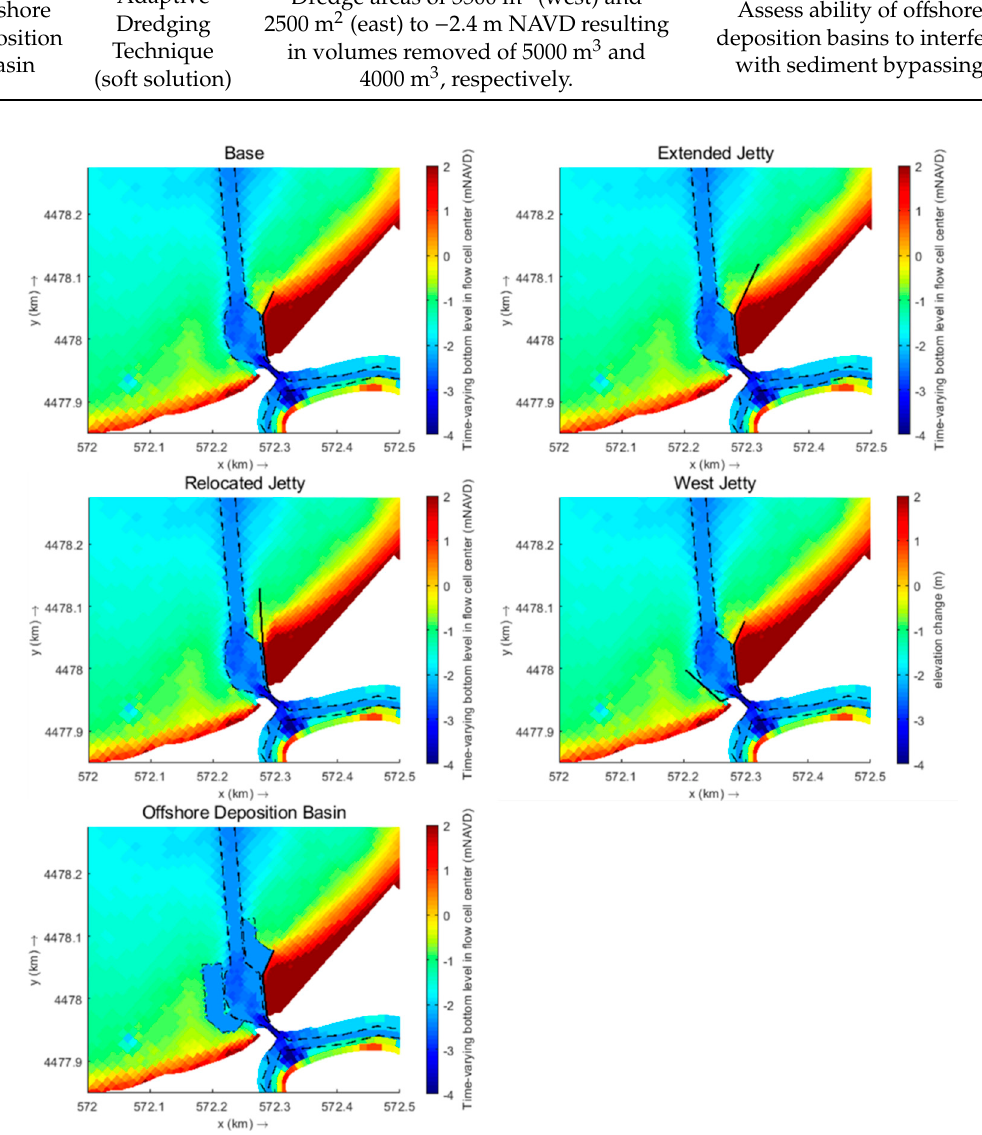
Figure 9. Modeled alternatives with initial bathymetry. Dredge template by dashed line, jetty by solid black line, and deposition basins by the dot and dashed